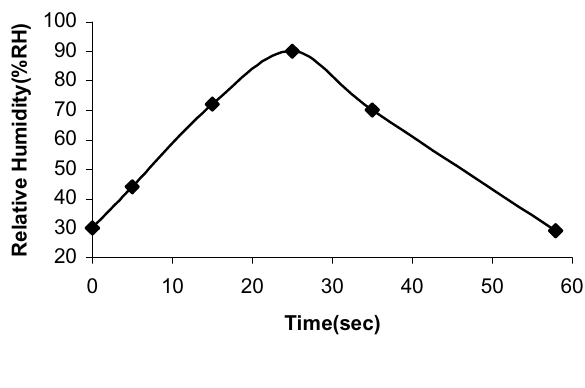
Figure 10. Time response of sample